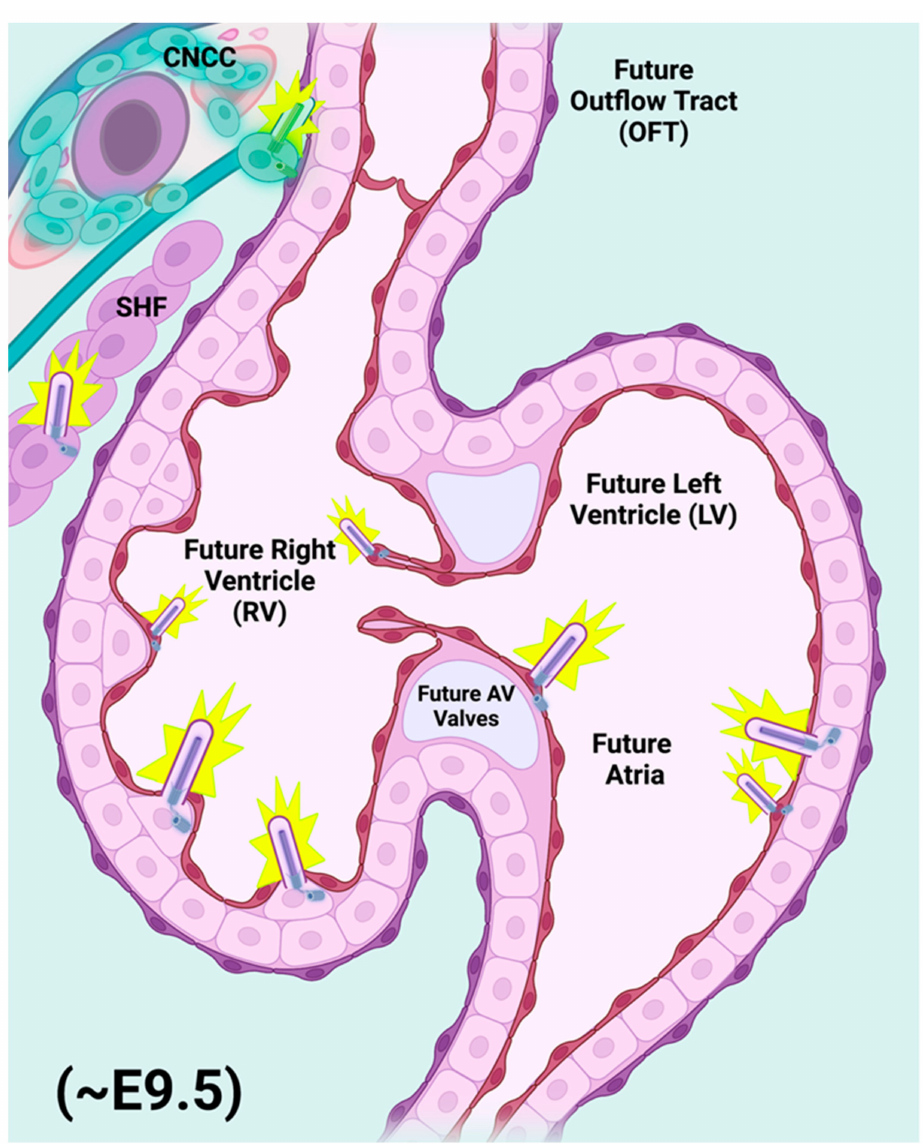
Figure 2. Primary cilia populate nearly all cell types of the developing embryonic heart. Repre- sentative E9.5 mouse heart showing elaboration of primary cilia (purple rods) from the cells of the migratory cardiac neural crest (CNCC) and second heart field (SHF) populations. As the embryonic heart begins to formalize its relative size and orientation, it receives an influx of migratory progen- itor contributions from both CNCC and SHF, which contribute both directly and indirectly to the developing cardiac outflow tract (OFT), endocardial cushions (ECC), and ventricular myocardial components during the final stages of cardiac looping and the beginnings of cardiac maturation phases, primarily septation of the OFT, and of the atrial and ventricular chambers. Primary cilia are also elaborated from many of the differentiated cells found within the heart chambers, including endothelial/endocardial and myocardial cells. The presence of a primary cilium on any one of the above cell types (progenitors included) inherently renders that cell with the sensitivity to respond to and even to be dependent upon Hedgehog signaling for appropriate proliferation, laterality, orienta- tion, polarity, and cell survival cues that are critical to mammalian heart development. The size and relative distribution of primary cilia illustrated above not to scale. Figure created with Biorender.com (accessed on 29 May